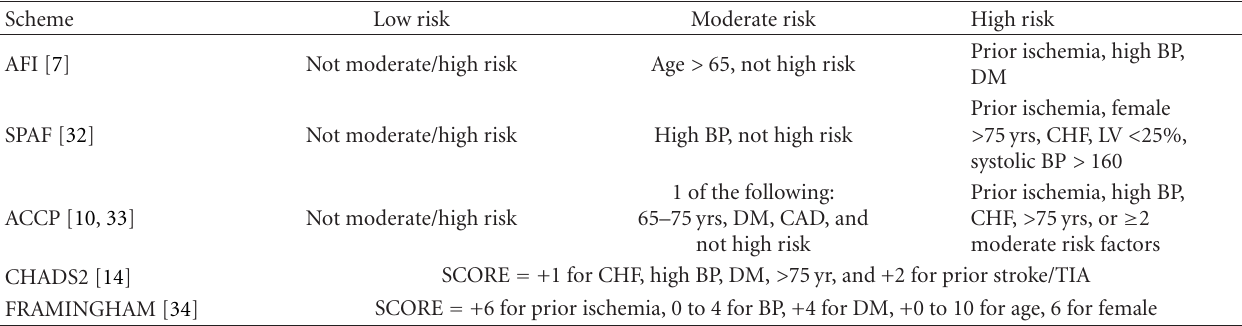
Table 2: Stroke risk stratifications schemes in patients with nonvalvular atrial fibrillation (BP: blood pressure, DM: diabetes mellitus, CHF: